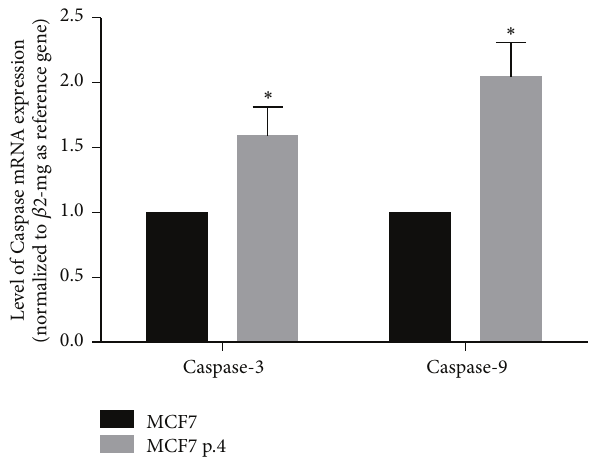
Figure 4: Level of Caspase-3 and Caspase-9 mRNA expressions after treatment with tamoxifen 1 𝜇 M at passage 4. Results were shown as mean ± SD ( 𝑁 = 4 ). ( ∗ ) Significant difference versus MCF7 parent cells at 𝑝 < 0.05 .